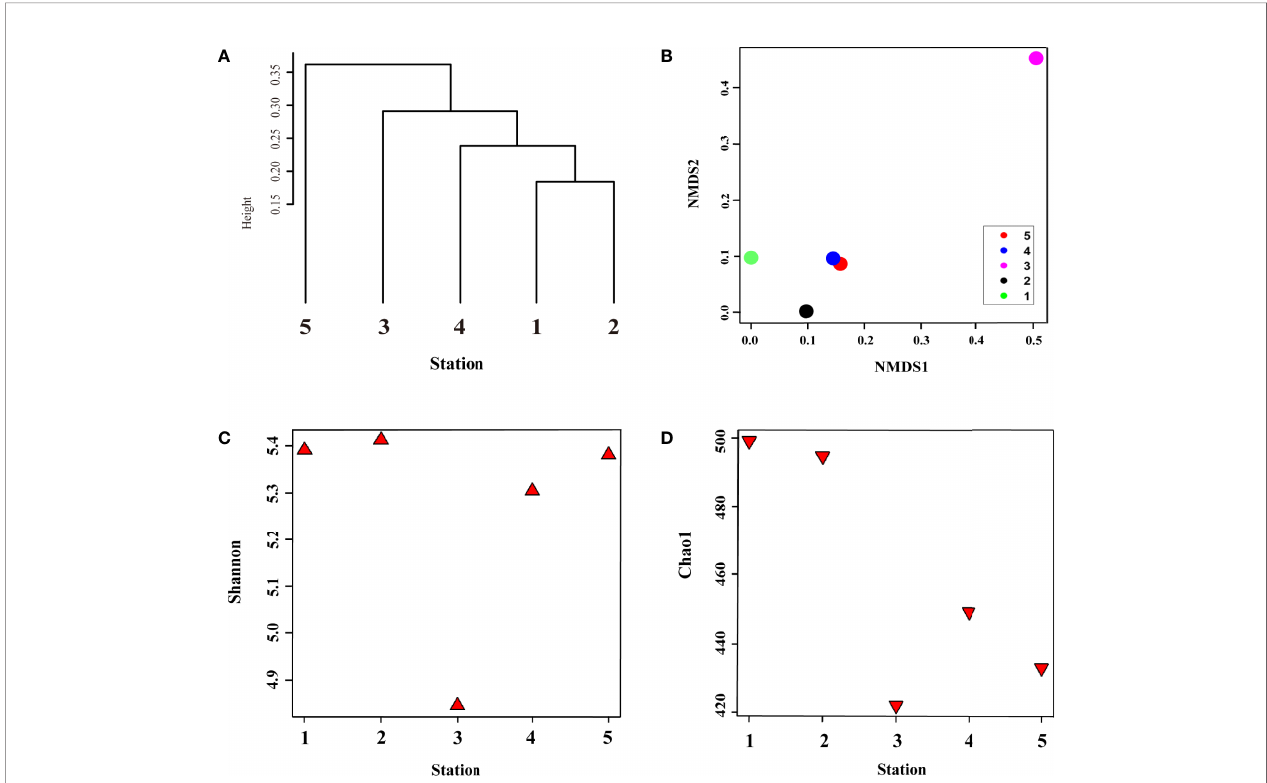
FIGURE 2 | Surface bacterial community composition similarity and differences in diversity and species richness in summer. (A) clustering of samples at the operational taxonomic unit (OTU) level based on Bray – Curtis distance; (B) dissimilarity of bacterial community composition using non-metric dimension scale (NMDS) plot based on unweighted-unifrac method; (C) diversity and (D) species richness represent the alpha diversity of surface bacterial community composition using Shannon and Chao1 indices,